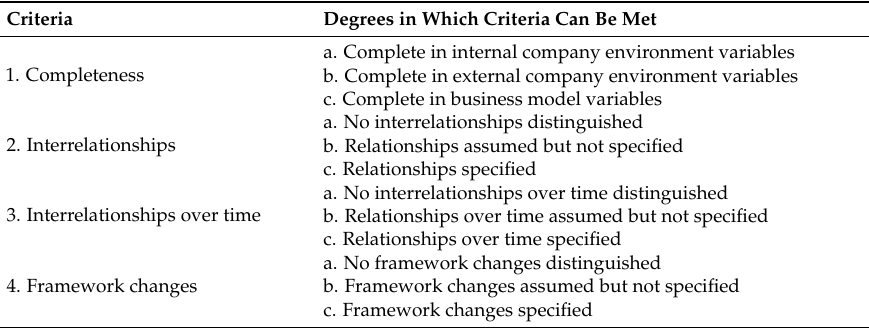
Table 1. The degree of dynamics in business model